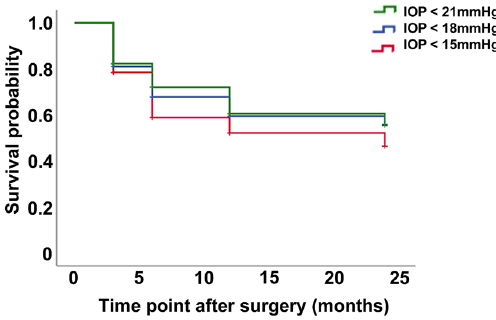
Figure 1. Kaplan–Meier survival analysis after the Trabectome surgery. Survival was defined by a postoperative intraocular pressure (IOP) < 21 mmHg and ≥ 20% reduction (green), IOP < 18 mmHg and ≥ 20% reduction (blue), and IOP < 15 mmHg and ≥ 20% reduction (red), all compared with baseline values with no additional treatments including IOP-lowering eye drops, oral CAI, or any ocular surgeries or laser therapies.